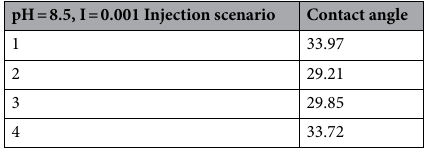
Table 5. Reported contact angle by Alshakhs and Kovscek 18 .